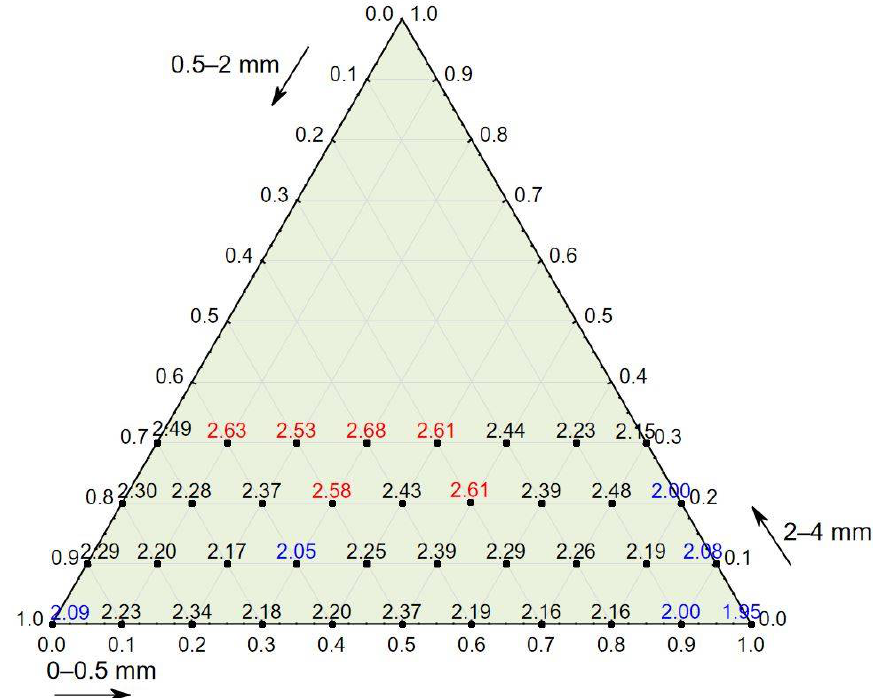
Figure 3. Splitting tensile strength of concrete in relation to the percentage of three aggregate fraction groups. Red represents a strength over 2.5 MPa, and blue represents a strength below 2.10 MPa. In order to determine the number of factors used in PCA [38], a scree plot of eigen- values was constructed. One can see that the “elbow” of the graph where the